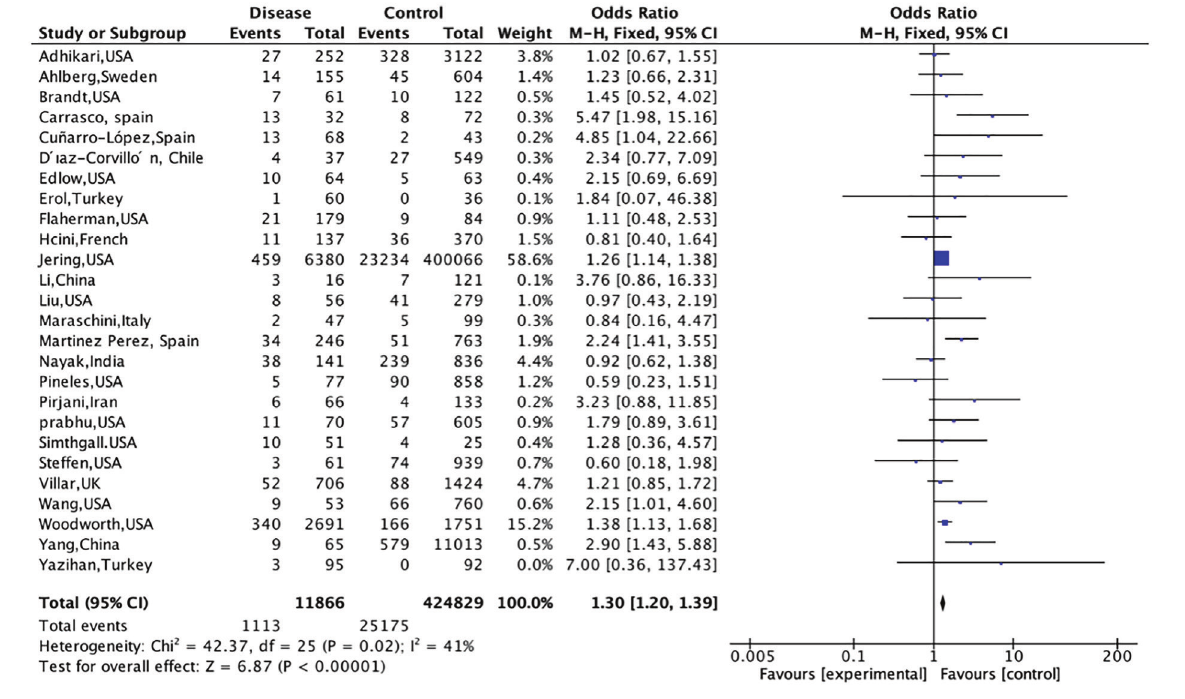
Figure 2 - Forest plots of summary crude odds ratios (ORs) and 95% confidence intervals (CIs) for the association between coronavirus disease 2019 (COVID-19) and preterm birth. (patients with COVID-19 versus patients without